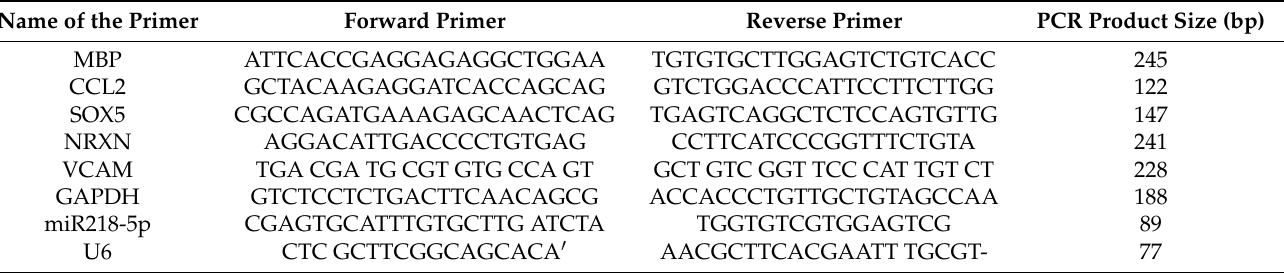
Table 1. Primers used to target the